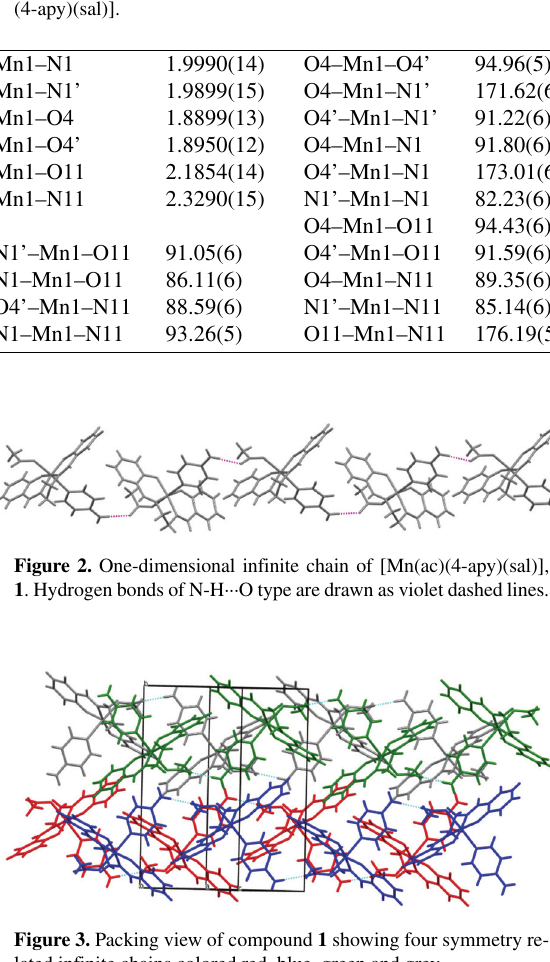
Table 2. Selected geometric parameters for compound 1 , [ Mn(ac) (4-apy)(sal) ] .